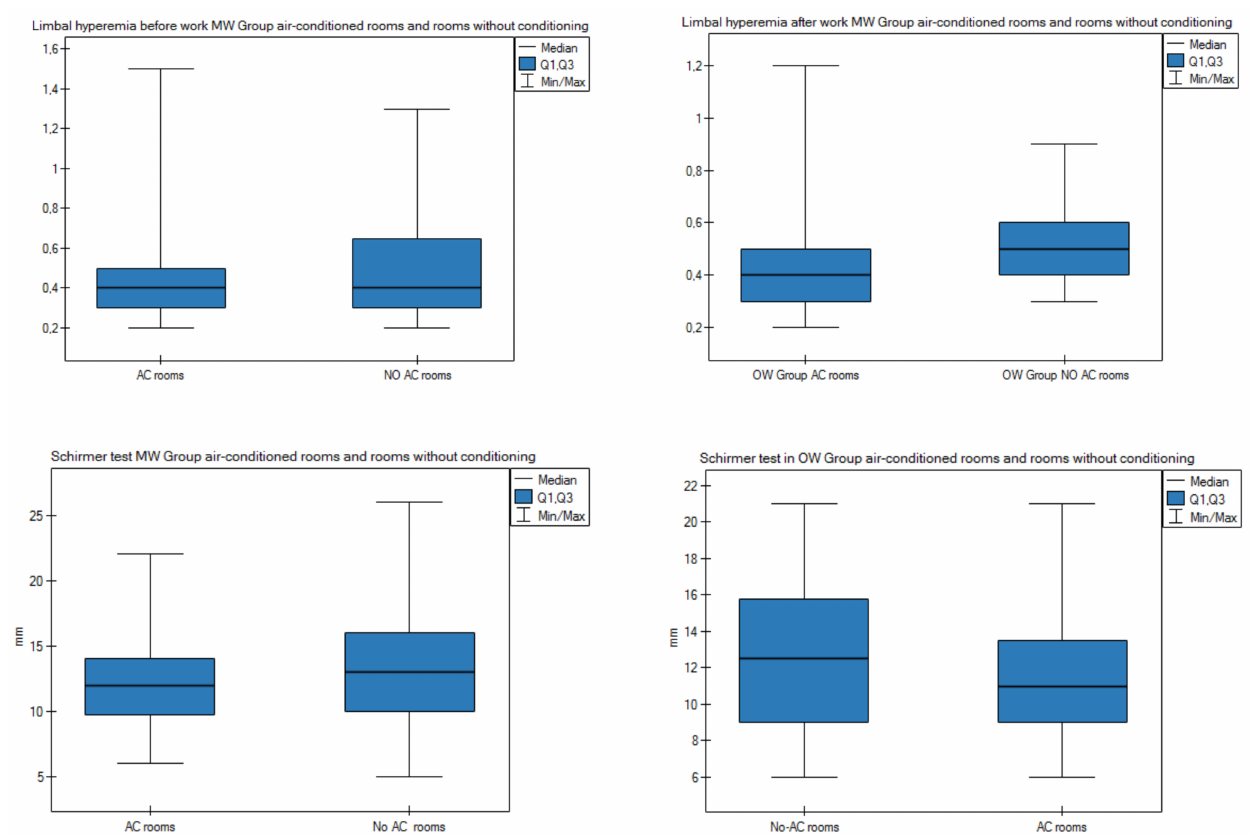
Figure 5. Comparison of the results of the parameters of the eye surface in the OW group and in the MW group in air-conditioned rooms and rooms without conditioning. Table S3 is available in the Supplementary